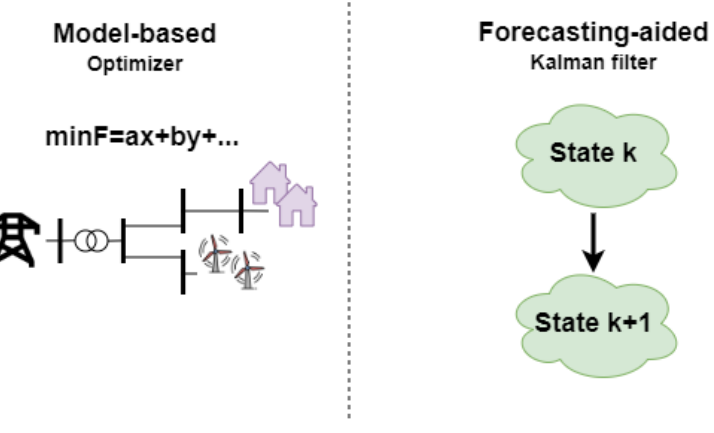
Figure 4. Main sorts of DSSE algorithms. Table 2. DSSE algorithms